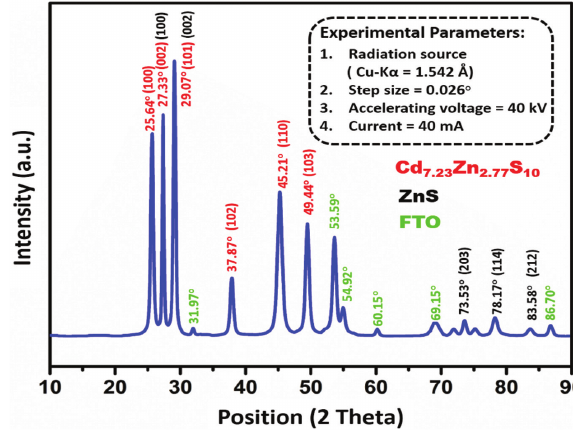
Figure 1: X-ray diffractogram of CIS thin films deposited on FTO substrate at 500°C via AACVD technique.